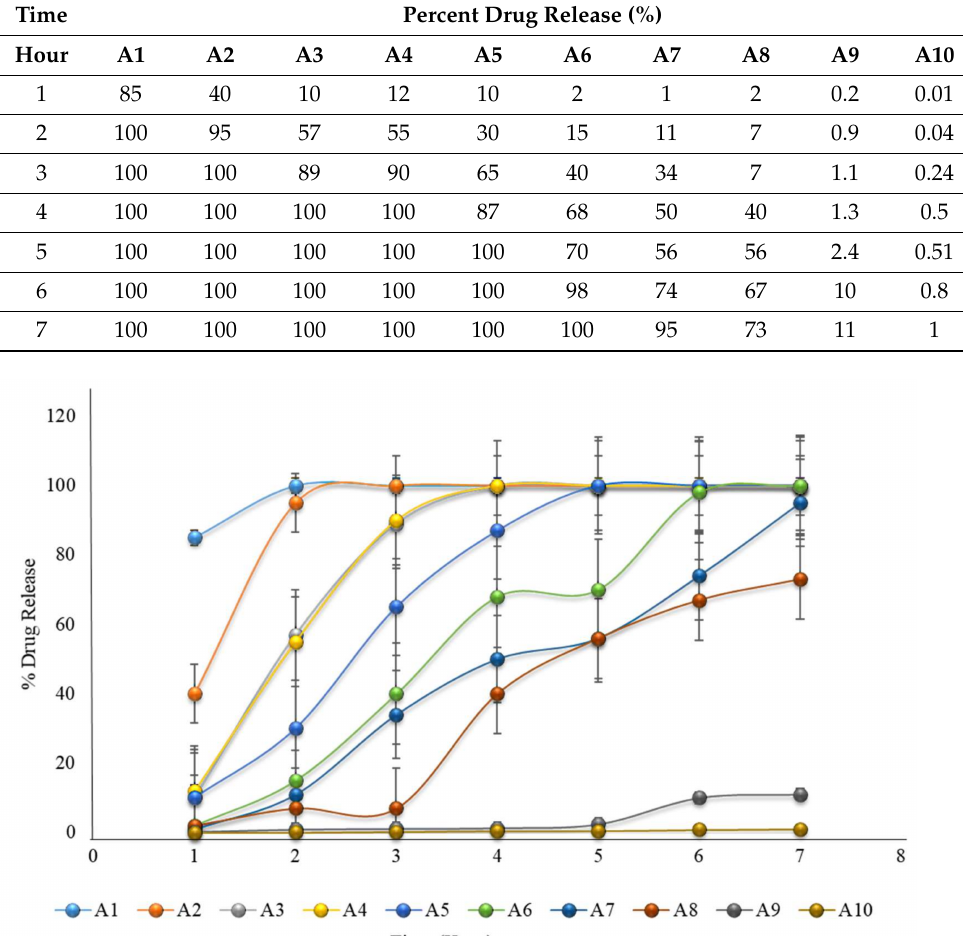
Table 5. The in vitro dissolution of formulations A1 to A10 (the first 2 h in an acidic medium of pH 1.2, then in a phosphate buffer medium of pH 6.8).